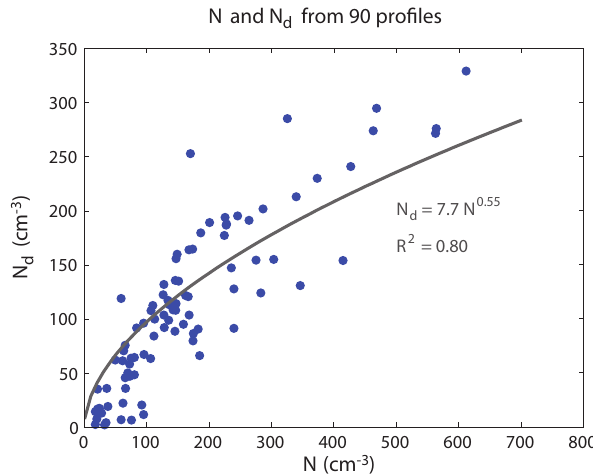
Fig. 2. PCASP measured aerosol concentration N and CDP mea- sured cloud droplet concentration N d from 90 profiles. N is the mean PCASP concentration at altitudes below 220m and N d is the mean CDP concentration (filtered for incloud). The gray line in- dicates the line of best fit, determined by the method described in Sect. 3.1.